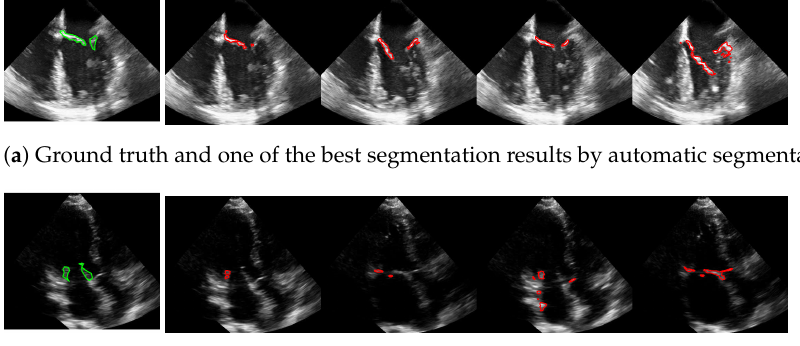
Figure 10. One of the best ( a ) and the worst ( b ) segmentation results by automatic segmentation (red), with the corresponding ground truth (green).